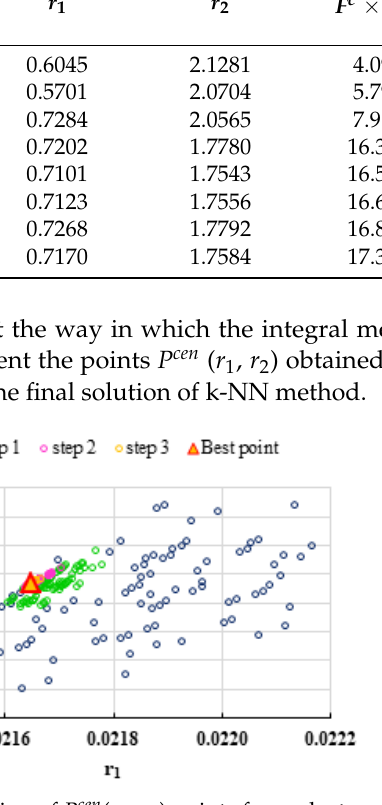
Table 20. Reactivity ratios obtained in the imposed conditions of HC3.